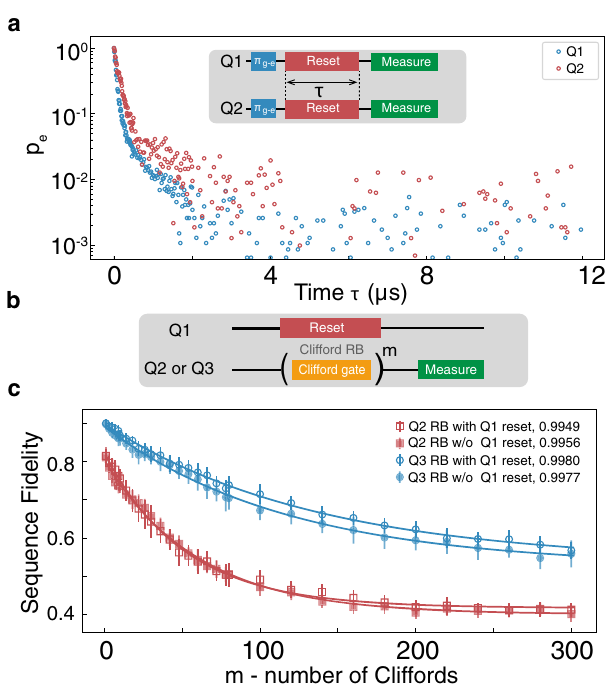
Fig. 5 Simultaneous parametric reset of Q1, Q2, and effects of reset pulse on adjacent qubits. a Time evolution of Q1 (blue) and Q2 (red) e j i state population when performing a parametric reset on both qubits simultaneously. The population remains at a steady low level from 2 μ s onwards. The pulse sequence for simultaneous parametric reset is inset. b Pulse sequence for Clifford-based randomized benchmarking (RB) on Q2(Q3). During the RB, either a parametric reset (with the same pulse duration as the m Clifford gates) was applied to Q1 or, for comparison, no pulse was applied to Q1. c RB results for the scenario described in b . The error bars are statistical (±1 s.d.) with 30 repetitions. The average single gate fi delity standard deviation is 0.08%(0.03%) for